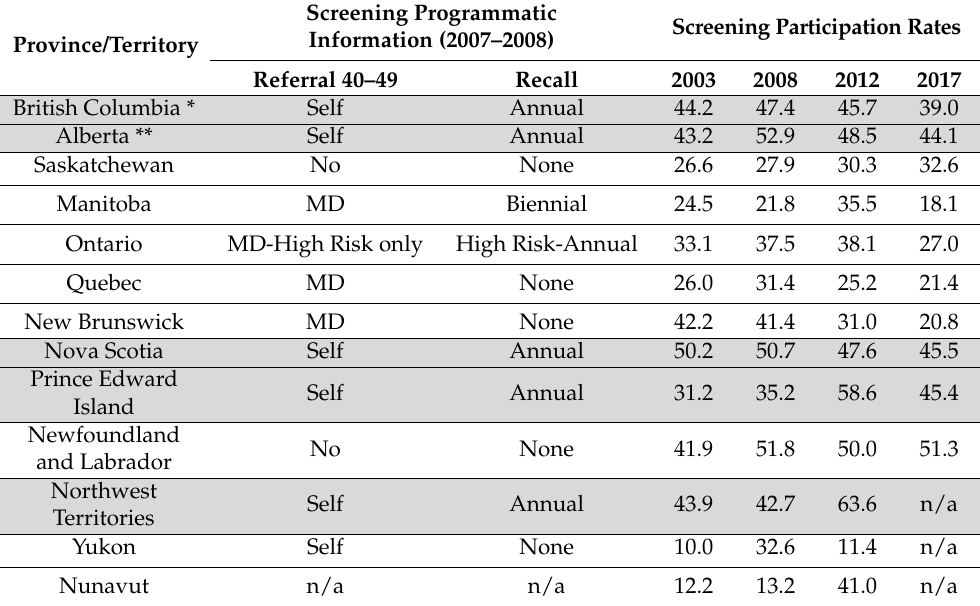
Table 1. Breast cancer screening information and participation rates by province and territory, women aged 40–49, Canada, selected